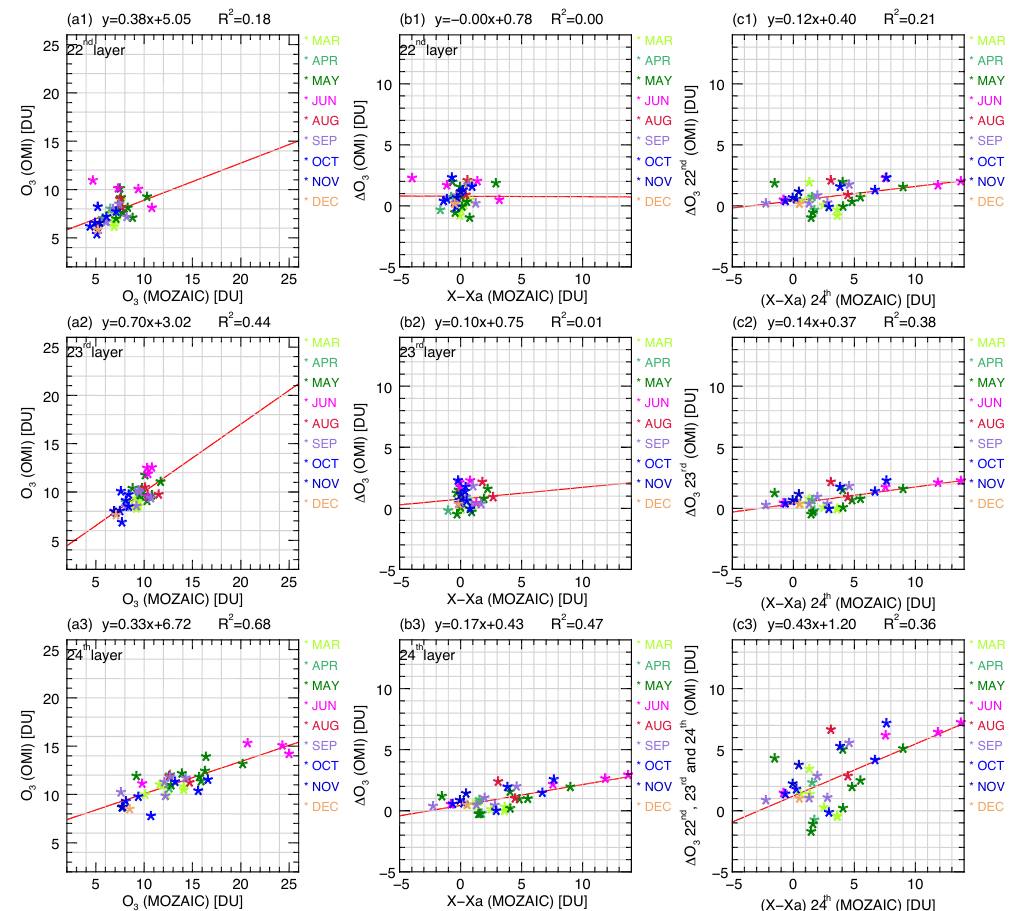
Figure 3. (Left) Direct correlation of MOZAIC ozone data (averaged to adjust for OMI height resolution) and OMI ozone retrievals at the (a1) 22nd, (a2) 23rd, and (a3) 24th layers for the coincident 36 days in 2004 and 2005. (Middle) Same as leftmost panels but for the differences from a priori values: X − X a taken from MOZAIC; (cid:49) O 3 taken from OMI. (1), (2), and (3) represent the 22nd, 23rd, and 24th layers, respectively, for each panel. (Right) Same as in the middle panels except that for (c1) X − X a taken from MOZAIC at the 24th layer and (cid:49) O 3 from OMI at the 22nd layer, (c2) X − X a taken from MOZAIC at the 24th layer and (cid:49) O 3 taken from OMI at the 23rd layer, and (c3) X − X a taken from MOZAIC at the 24th layer and the summation of (cid:49) O 3 taken from OMI at layers 22 to 24. The linear regression equation and coefficient of determination, or R 2 values, are shown above each panel. All data are color coded according to month. The 36-day data used in the analysis are listed in Table